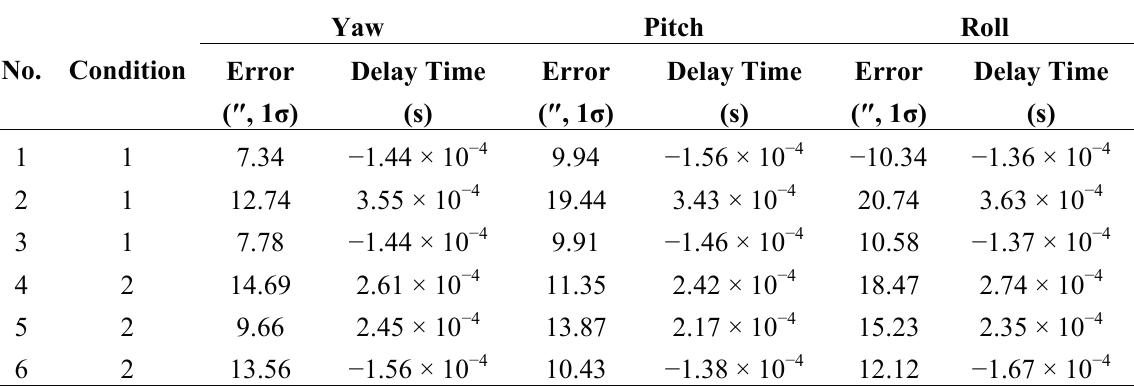
Table 6. DAMS three axis wobbling test results (10 min).